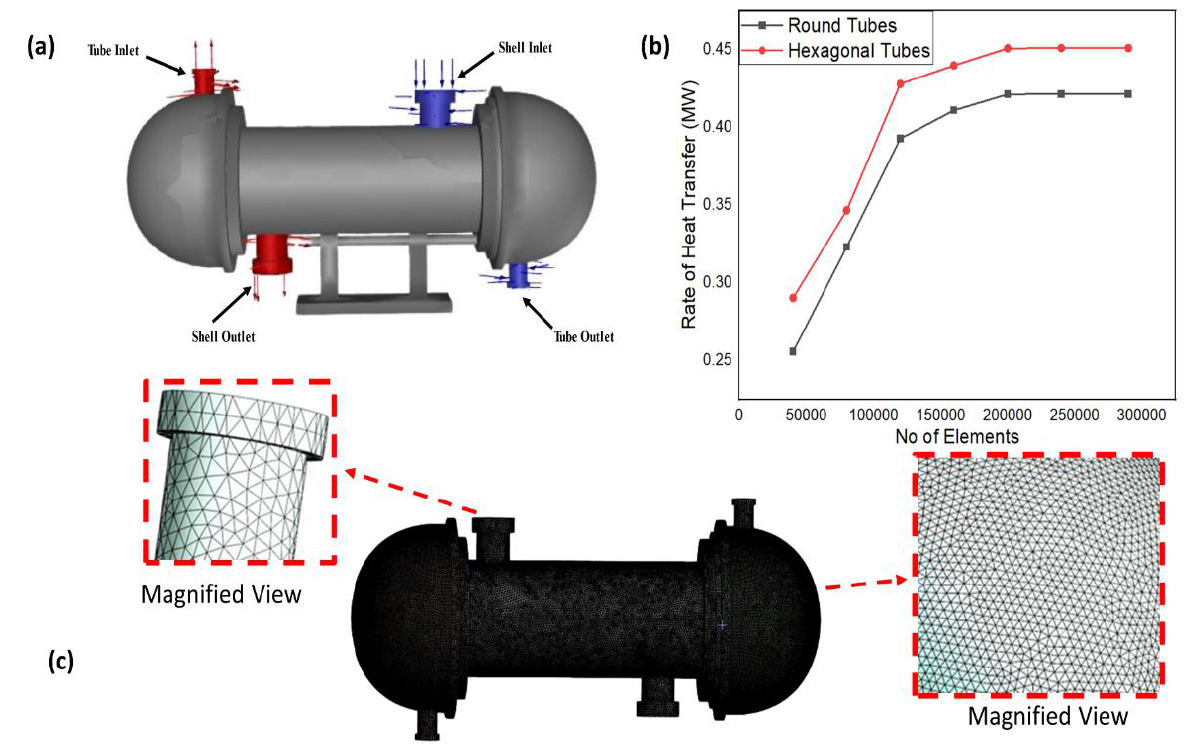
Figure 3. ( a ) Computational domain showing the inlets and outlets for shell and tube fluids; ( b ) mesh independence rest line plot; ( c ) meshing sample along with magnified views.